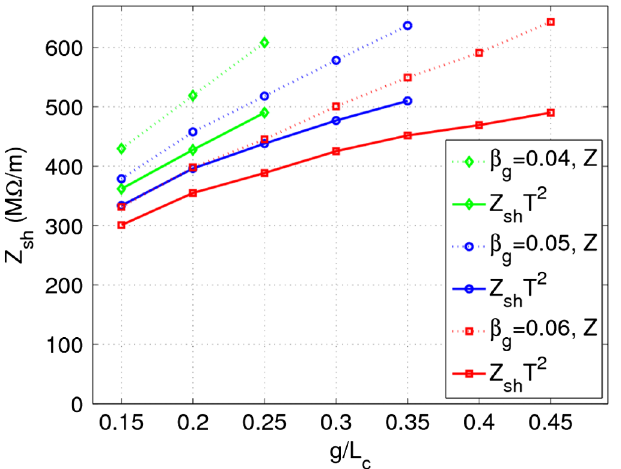
FIG. 7. Shunt impedance (dotted lines) and effective imped- ance (solid) of the IH structures with vanes versus the relative width of the gap between